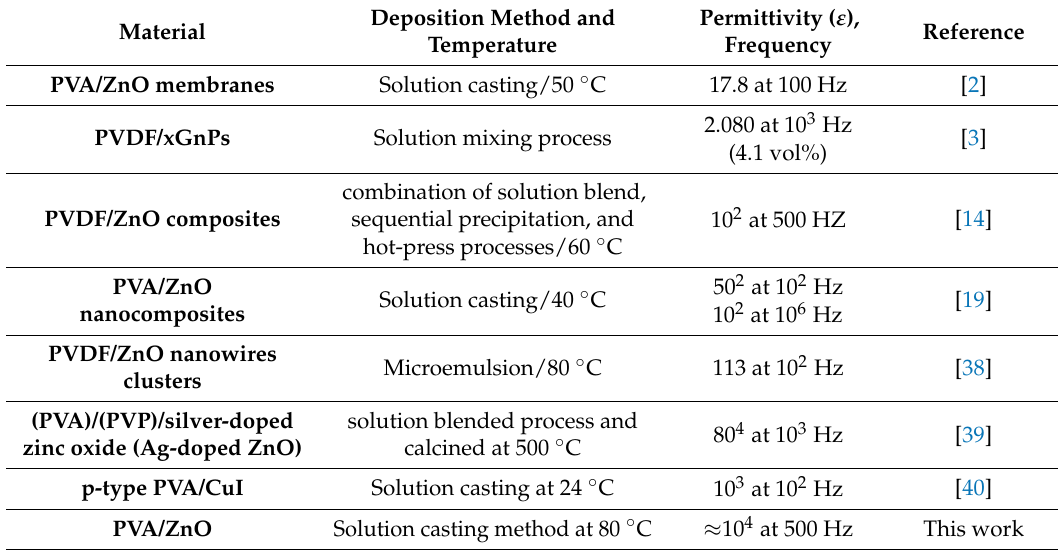
Figure 14. Frequency dependence of dielectric loss ε ” for PVA/ZnO composites.